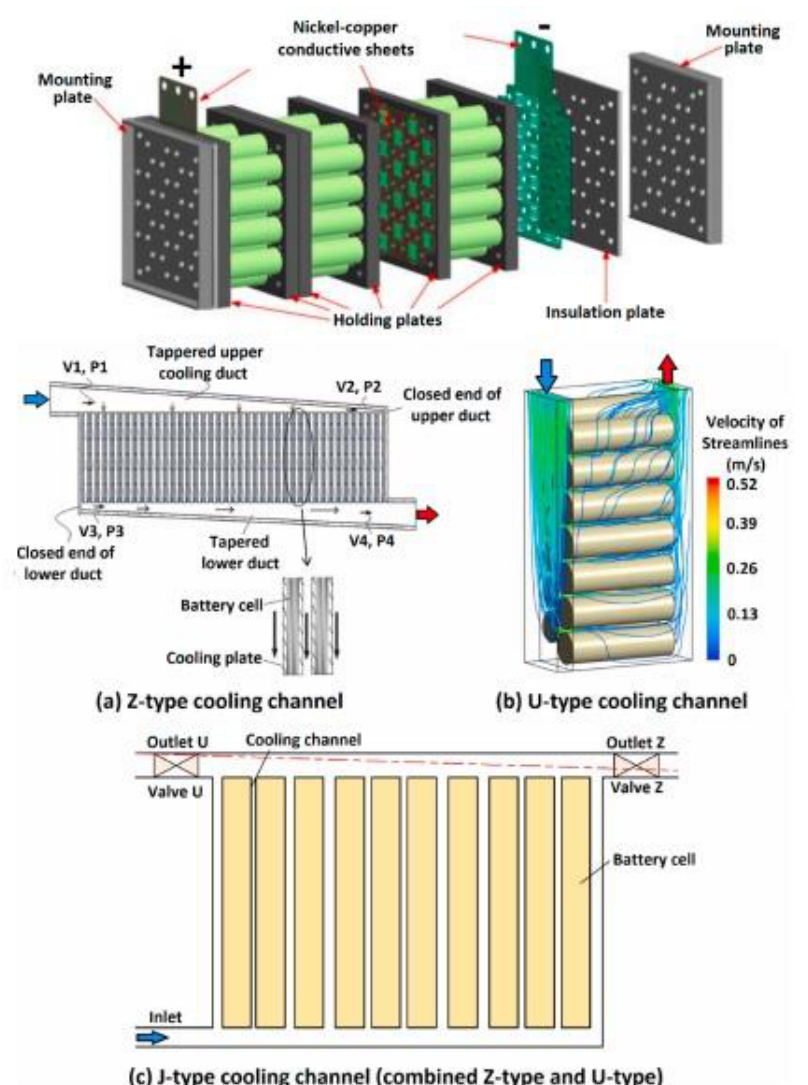
Figure 16. Air-based thermal management, as one of the most convenient forms of techniques, can be optimized using a different configuration of the cooling channel [( a ) Z, ( b ) U, or ( c ) J type] [16,97] . Reprinted with permission from [97] . Copyright 2021 Elsevier.